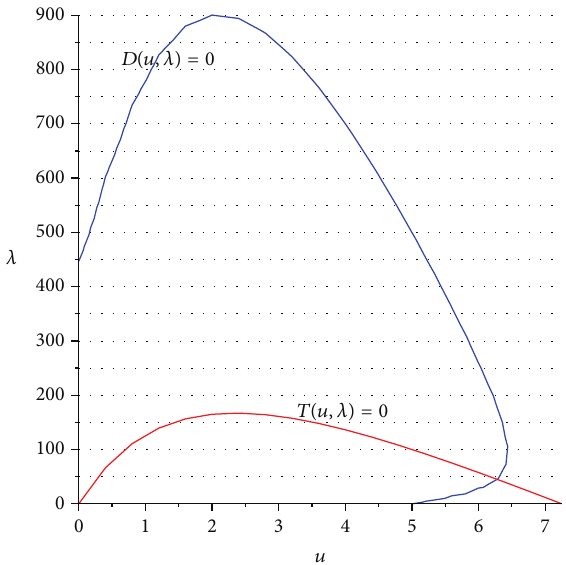
Figure 4: The graph of 𝑇(𝑢,𝜆) = 0 and 𝐷(𝑢, 𝜆) = 0 , where 𝑑 1 = = 0.004 , 𝑒 = 0.5 , 𝑎 = 1 , 𝑛 = 5 , 𝑚 = 5 , 𝜇 = 0.4 , 𝑟 = 2 , and 0.001 , 𝑑 2 𝐾 = 10 . In this case, 𝑢 ∗ ≤ 𝑚 .